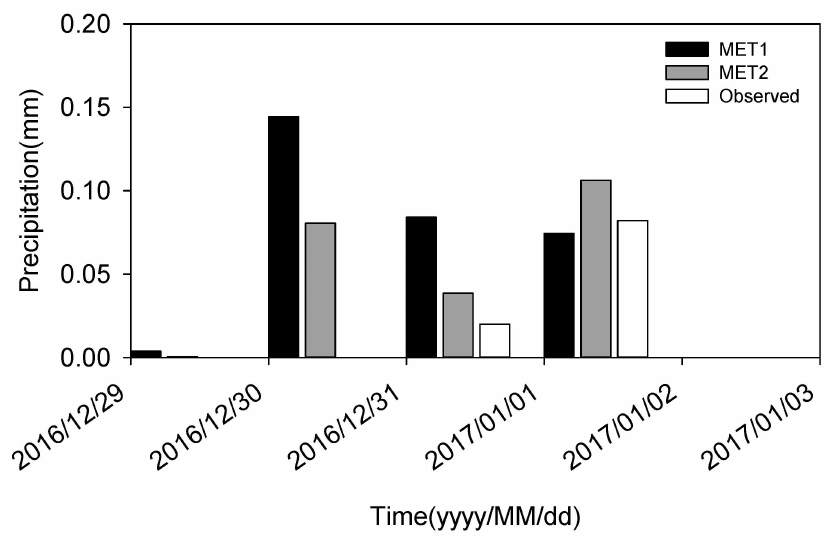
Figure 7. Histogram of hourly the 24 h averages of the observed precipitation (unit: mm) from 29 December 2016 to 02 January 2017 (white bar) and simulated precipitation of MET1 (black bar) and MET2 (grey bar).